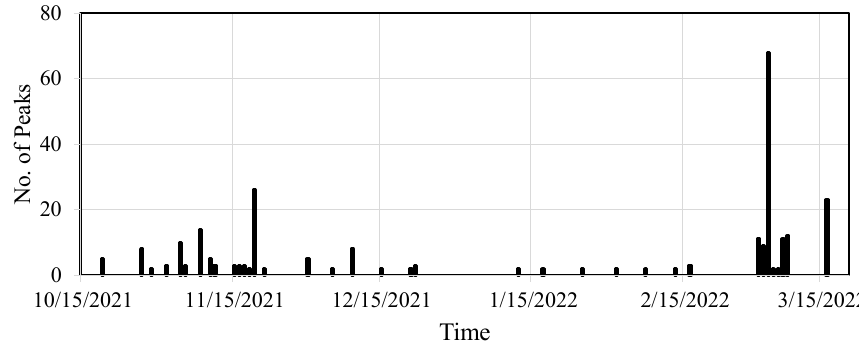
Figure 22. Monitored CGI(cid:3364)(cid:3364)(cid:3364)(cid:3364)(cid:3364) and standard deviation.